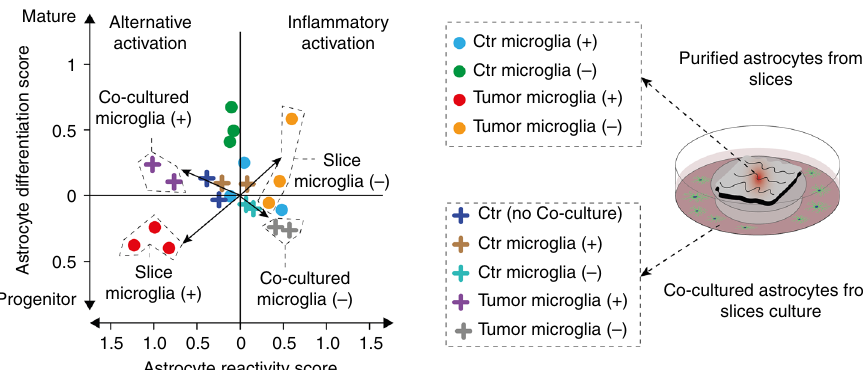
Fig. 4 Transcriptional pro fi ling of astrocytes from the human organotypic slice model. Scatterplot of astrocytic differentiation and reactivity reveals a shift in puri fi ed astrocytes from all experimental conditions and co-cultured astrocytes towards the progenitor phenotype and alternative reactivity. Astrocytes puri fi ed from slices are illustrated by dots, astrocytic cell lines marked by crosses. List of analyzed genes is given in the source fi le (Source File Fig.